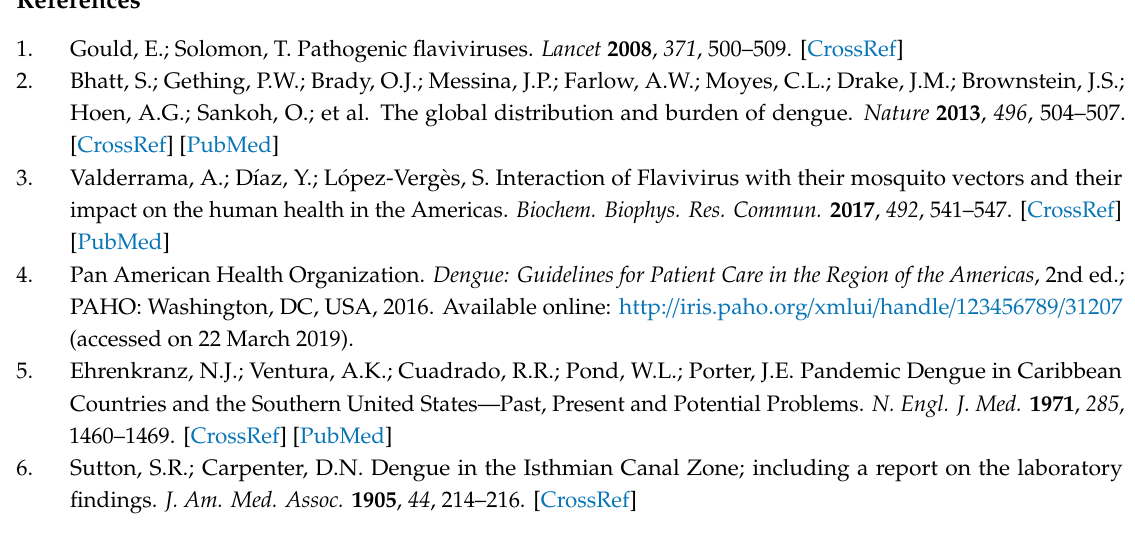
FigureS1: Political mapofPanama. FigureS2: Circulatingserotypes inPanamafrom 1993to2017. TableS1: Primers used for Dengue E sequencing. Table S2: GenBank Sequences from other countries used for the phylogenetic analysis. Table S3: Incidence of Dengue cases per age group from 1999 to 2017. Table S4: Hospitalization due to dengue disease according to age